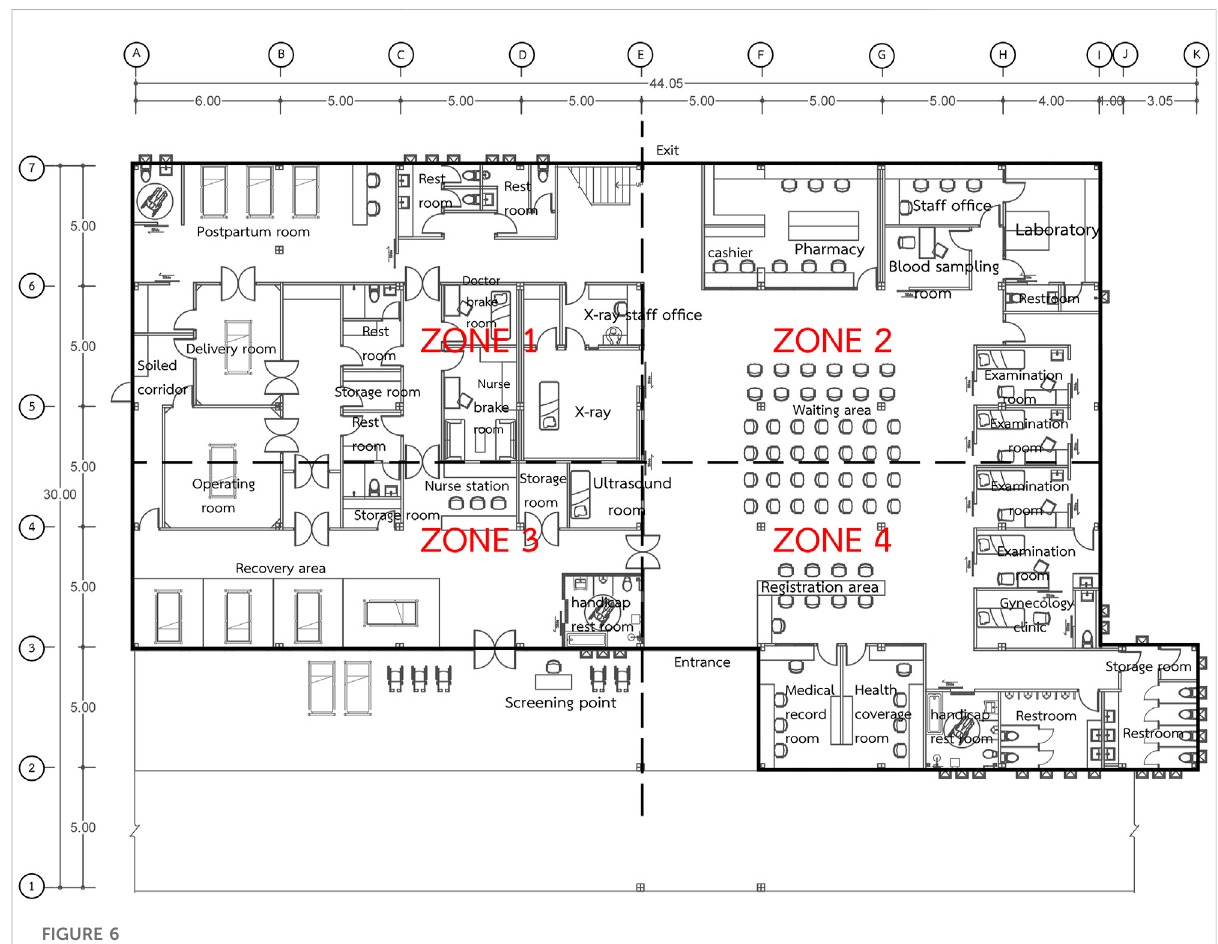
FIGURE 6 New layout of no. 3130